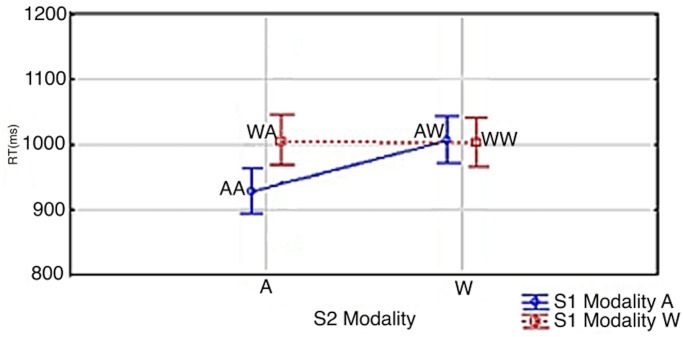
S1 Modality x S2 Modality.Vertical bars denote 0.95 confidence intervals for repeated measures ANOVA (Hollands & Jarmasz, 2009). S1 and S2 modality is signified by ‘A’ and ‘W’; ie. Arabic Digit (A) vs. Written Number Word (W). As an example, AW signifies an Arabic digit at S1 and a written number word at S2.